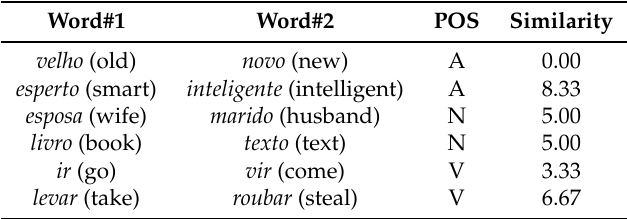
Table 1. First two adjectives, nouns and verbs of the Portuguese SimLex-999, with original English translation.